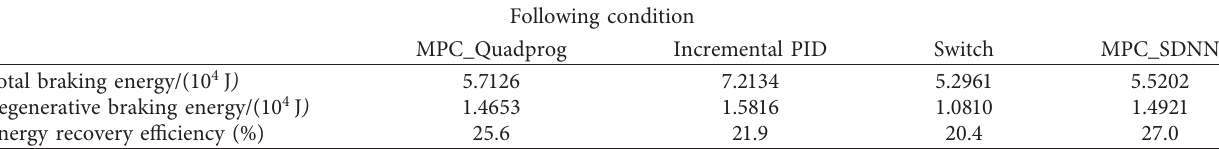
Figure 15: Regenerative braking energy of four controllers. Table 12: Performance of energy recovery in braking in the following